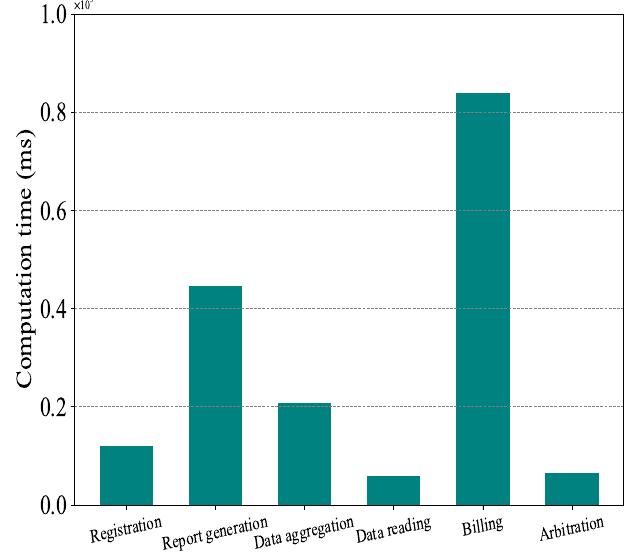
Figure 5. Computation time in each phase ( n =